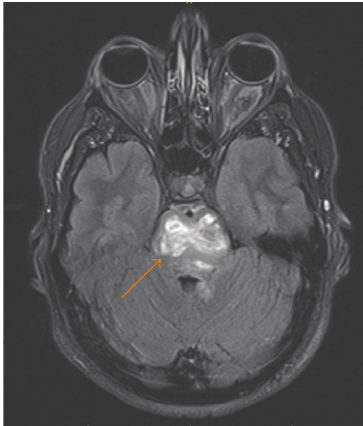
Figure 9: A 35-year-old male with axial T2-weighted FLAI image showing heterogeneous, predominantly hyperintense signal in the pons (arrow).